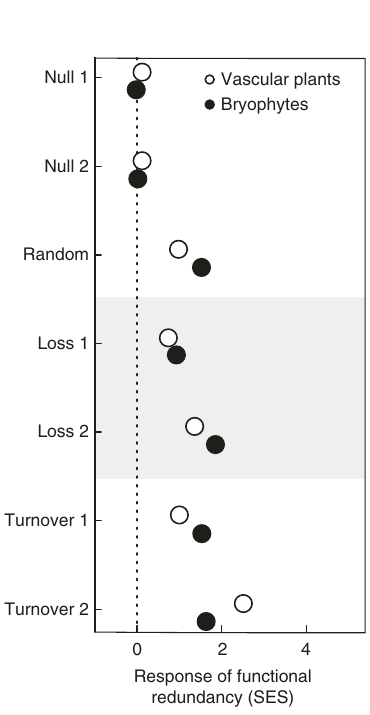
Fig. 6 Effects of modelled species assembly scenarios on functional redundancy. The response of plant functional redundancy to seven different assembly scenarios (see text for a description) as compared to the observed functional redundancy, expressed as the deviation of the standardized effect sizes (SES) from